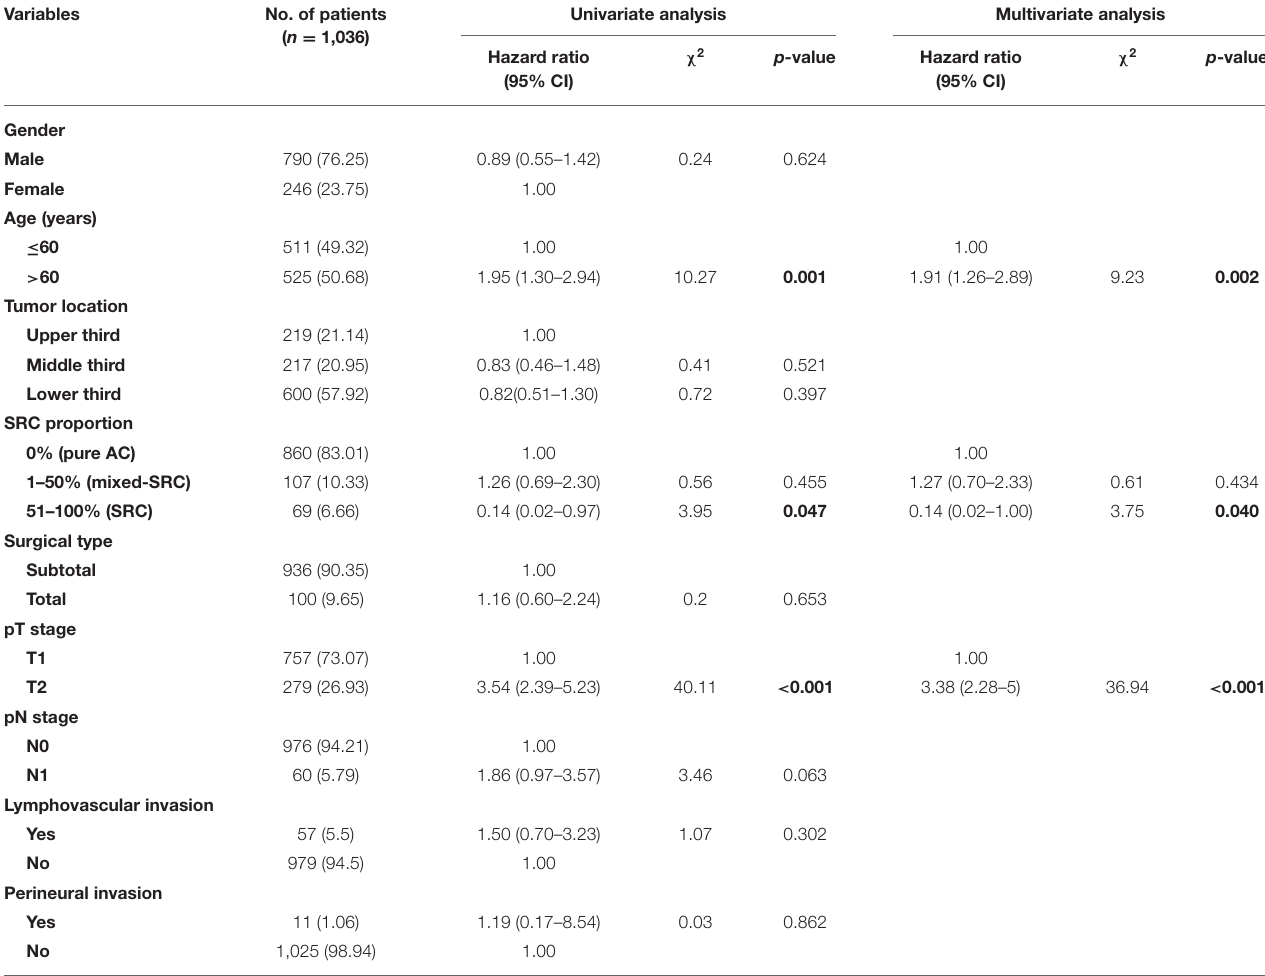
TABLE 2 | Univariate and multivariate COX regression analysis for OS of patients with stage I GC. Variables No. of patients Univariate analysis Multivariate ( n = 1,036)